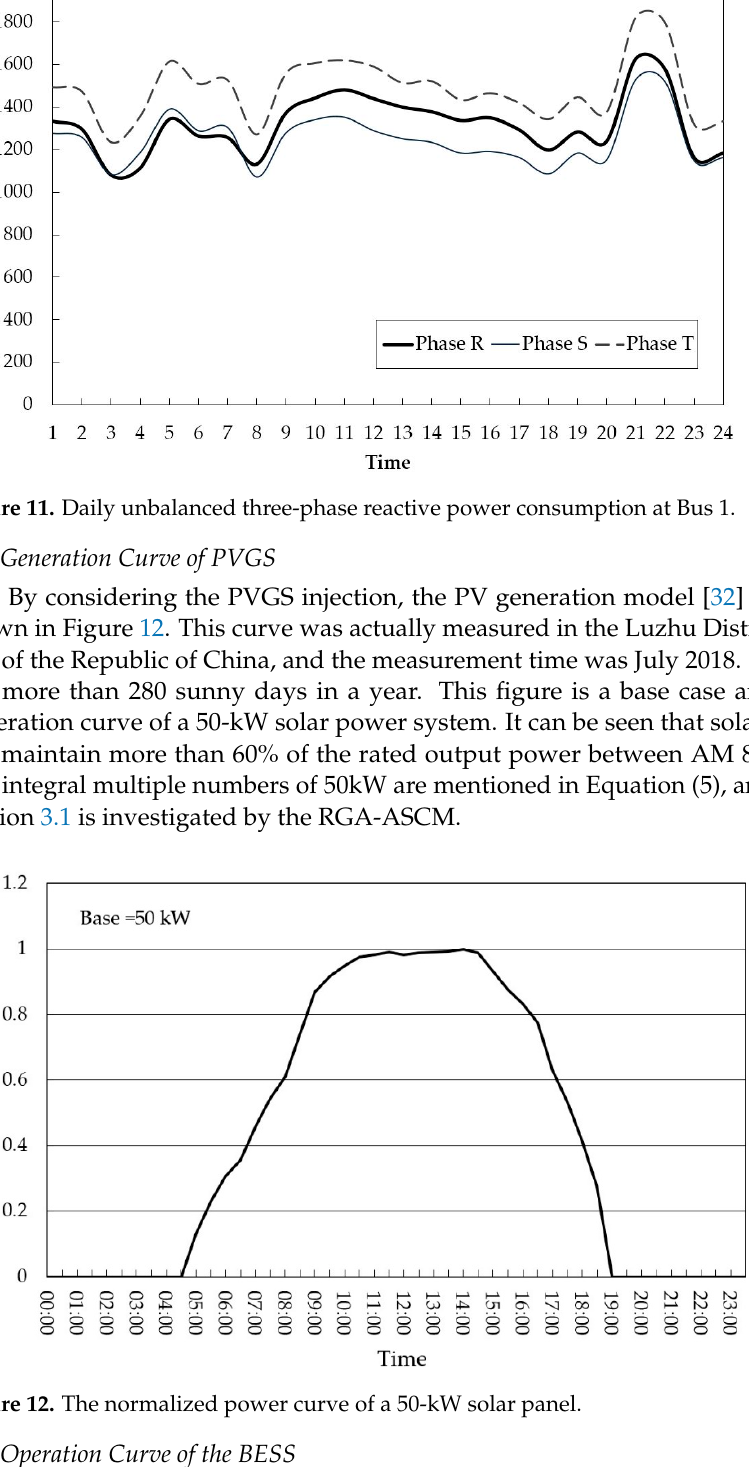
Figure 10. Daily unbalanced three-phase active power consumption at Bus 1.